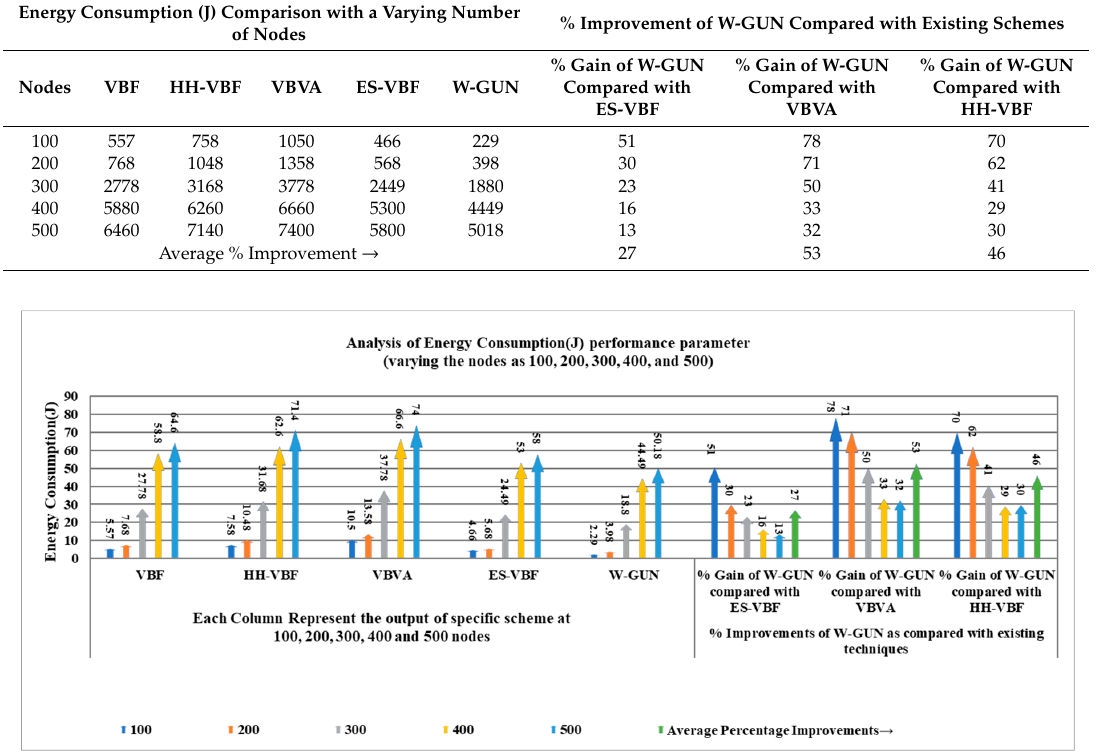
Figure 8. Detailed percentage-centric performance gain of W-GUN focusing energy consumption.